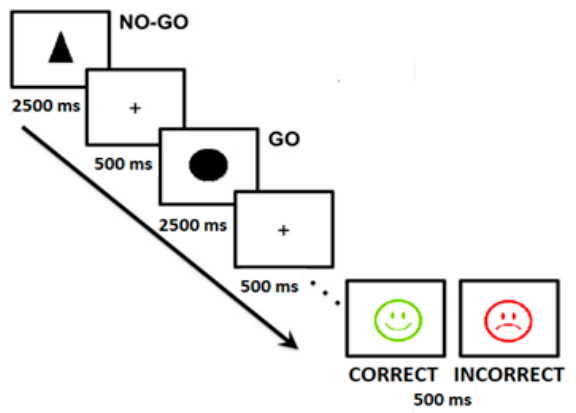
Figure 1. Go-no-go task employed in terms of corrective feedback. Procedure and time exposure (maximum of 2500 ms until participant’s response). (maximum of 2500 ms until participant’s